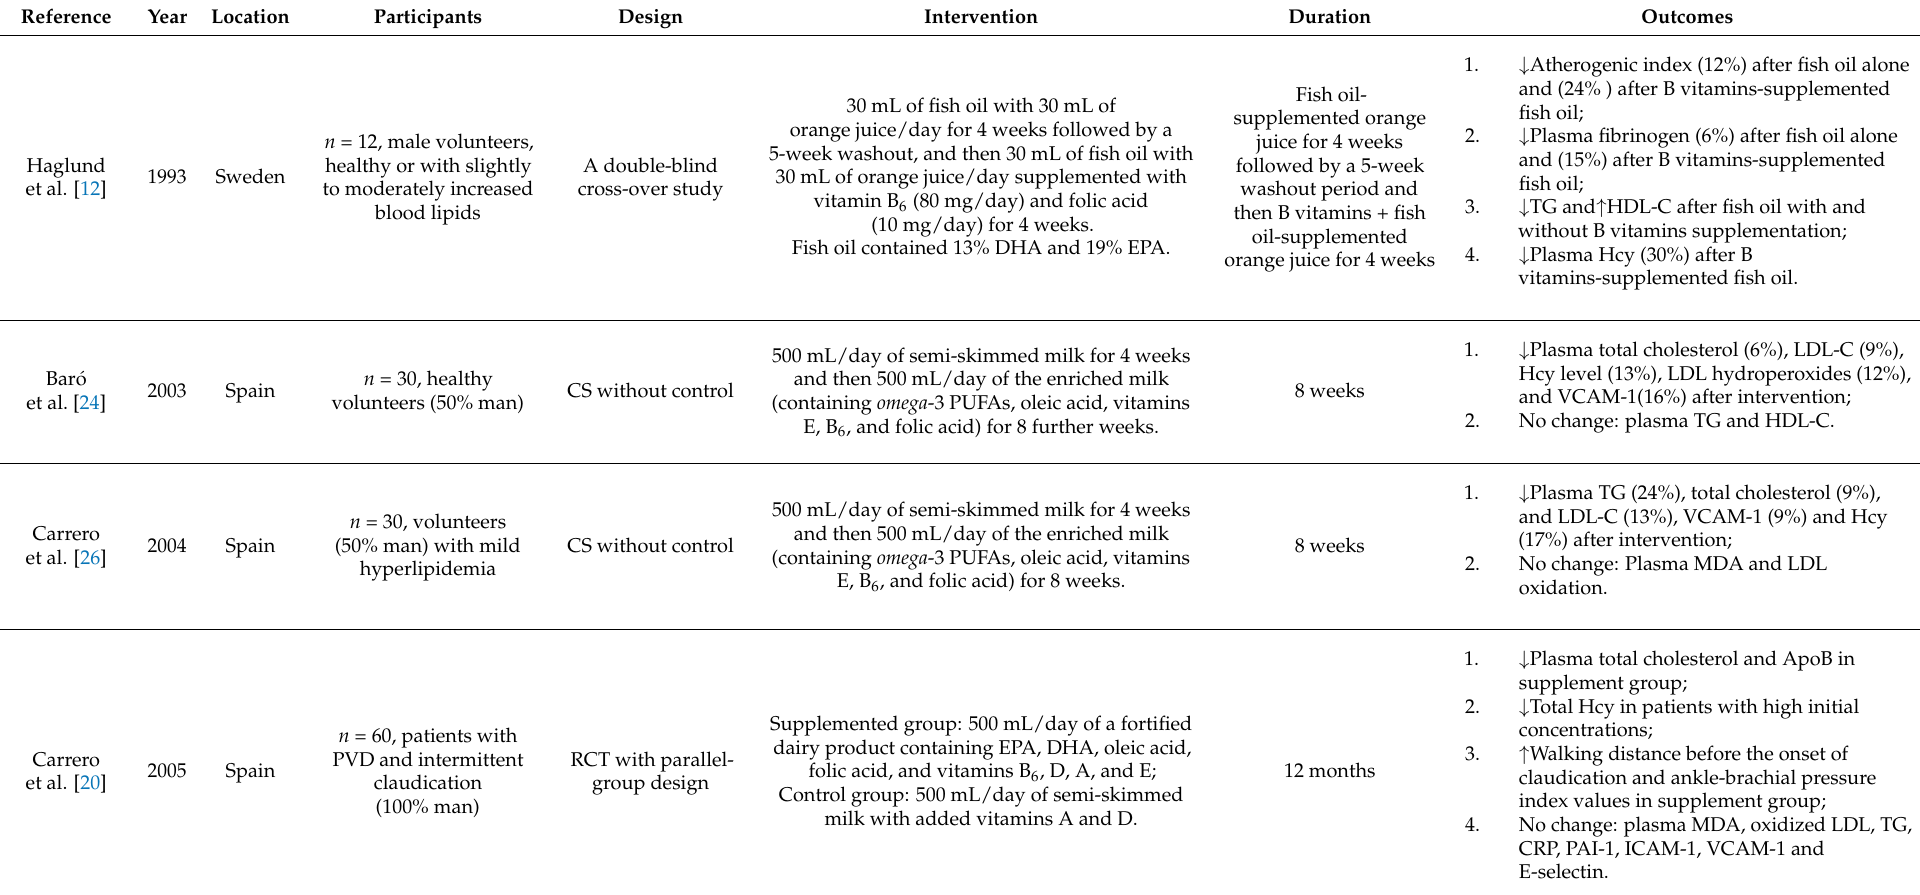
Table 1. Characteristics of the studies included in the systematic